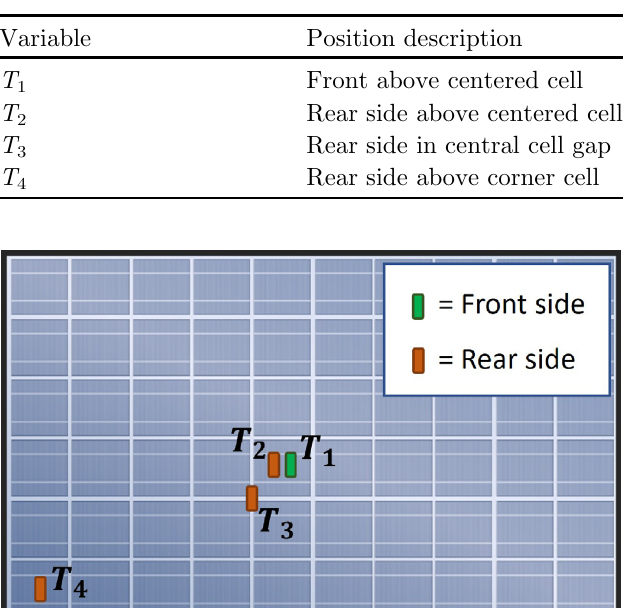
Table 3. Description of T -thermocouple positions as depicted in Figure 2.